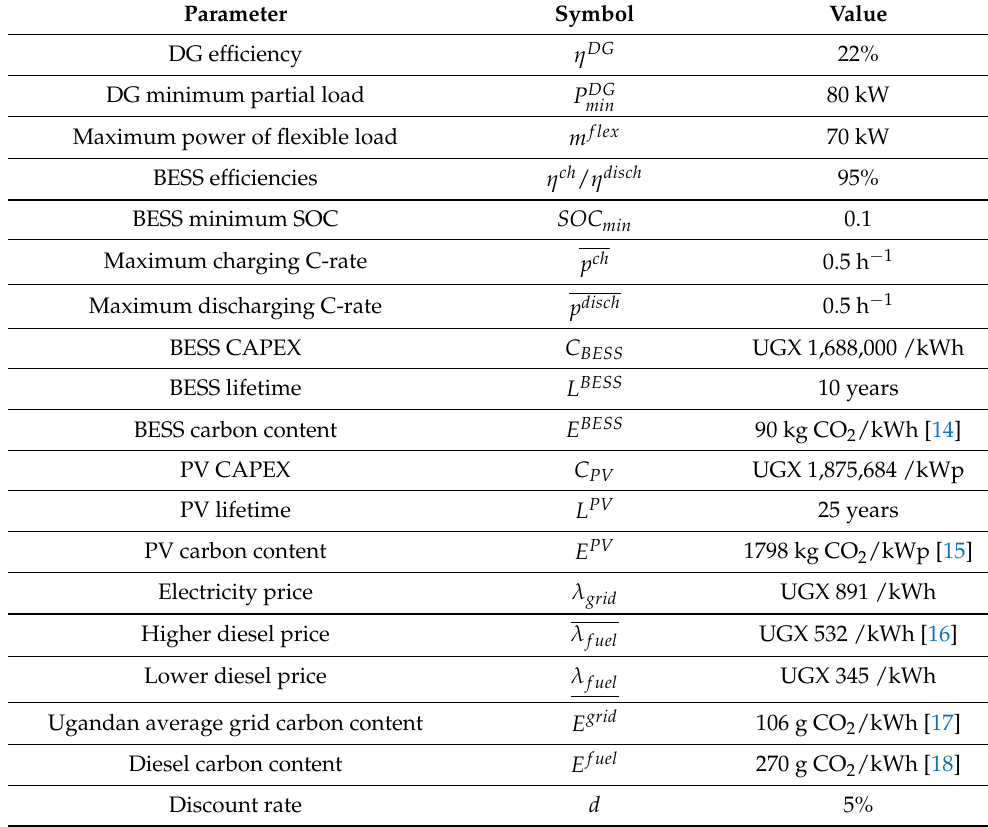
Table 5. Techno-economic